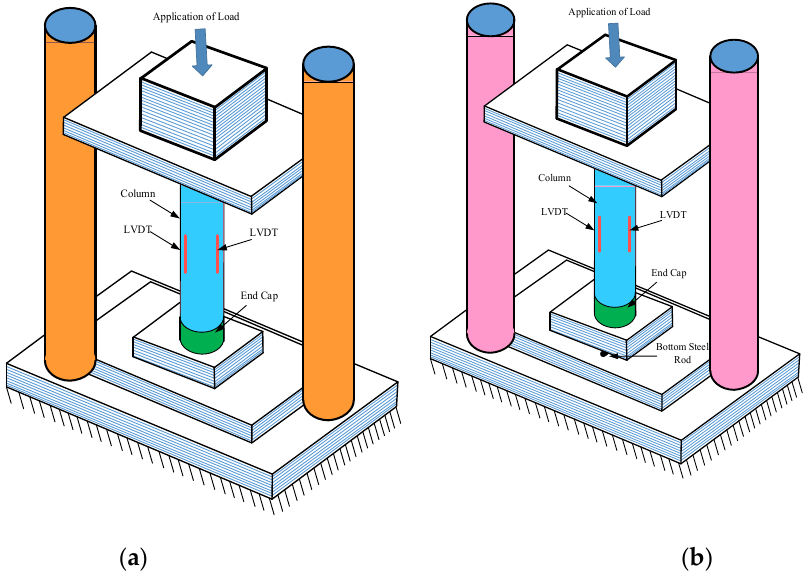
Figure 3. Experimental setup of specimens ( a ) concentric specimens ( b ) eccentric